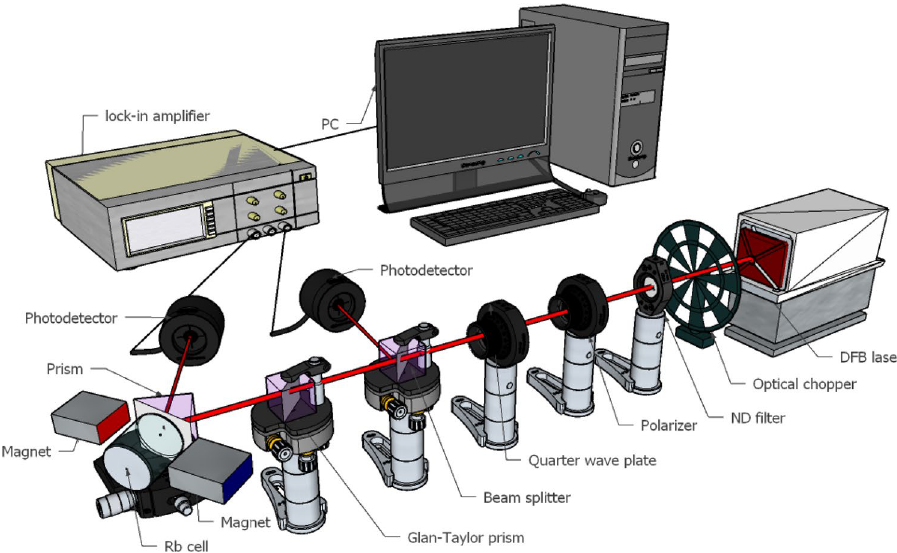
Figure 2. Optical setup used for magneto optical evanescent wave spectroscopy in the Faraday